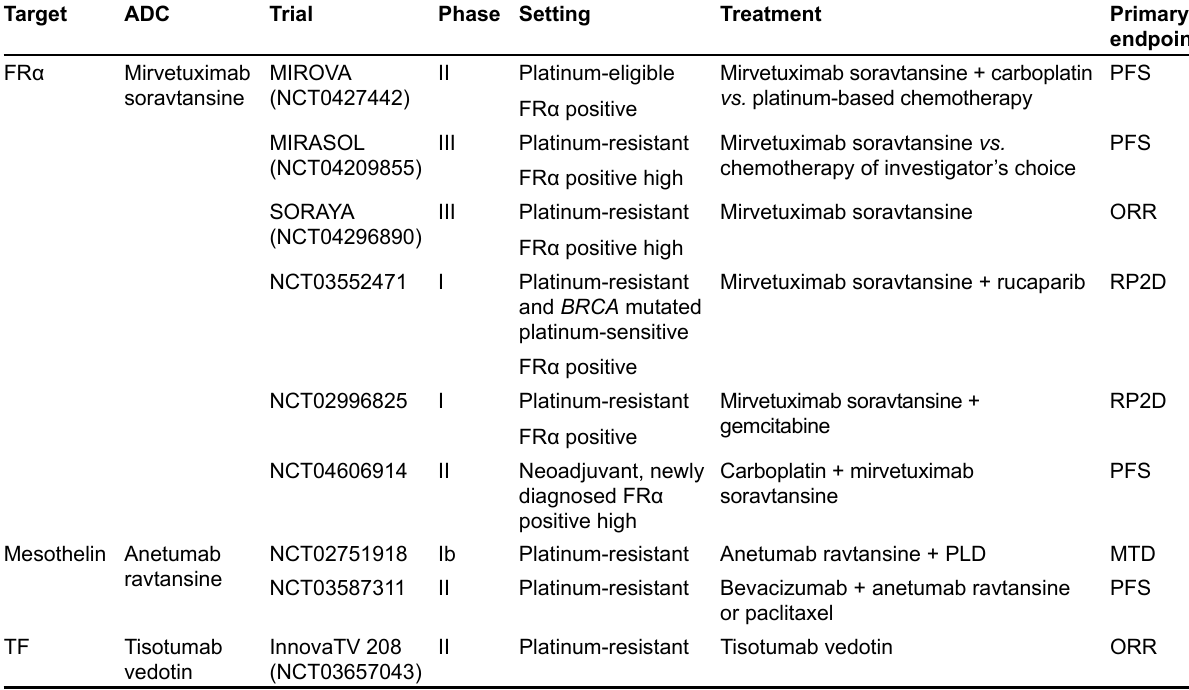
endpoint PFS PFS